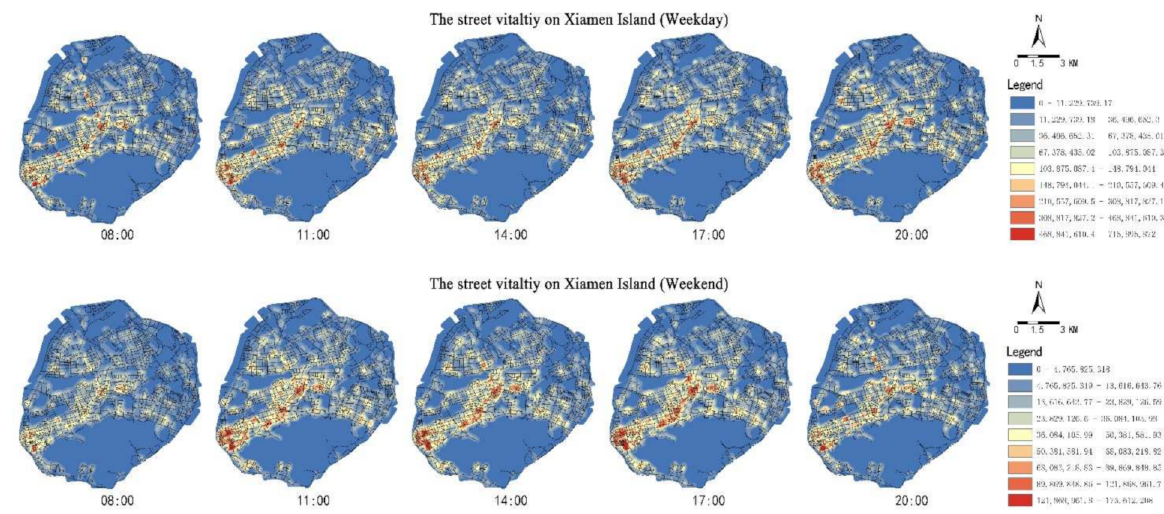
Figure 5. Spatial and temporal distributions of the street vitality on Xiamen